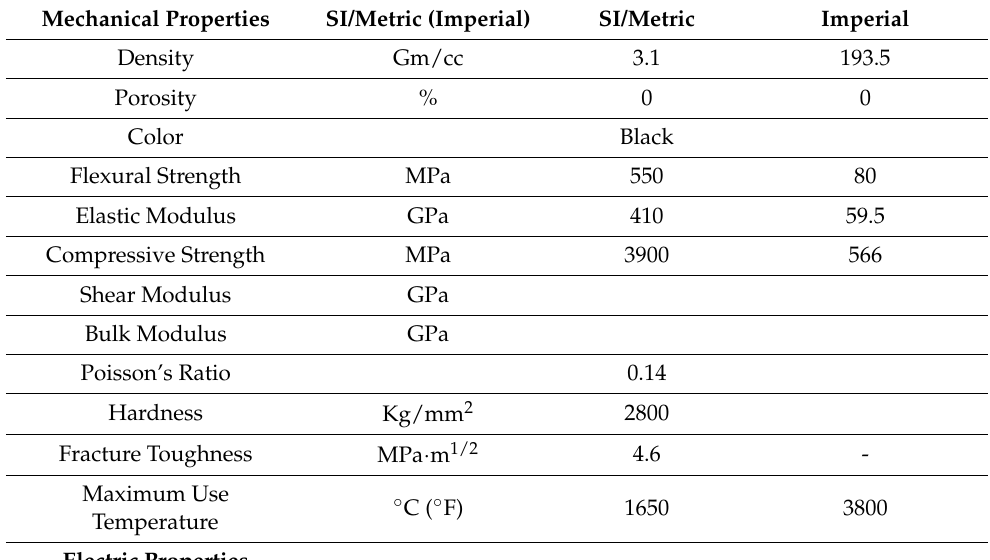
Table 2. Properties of